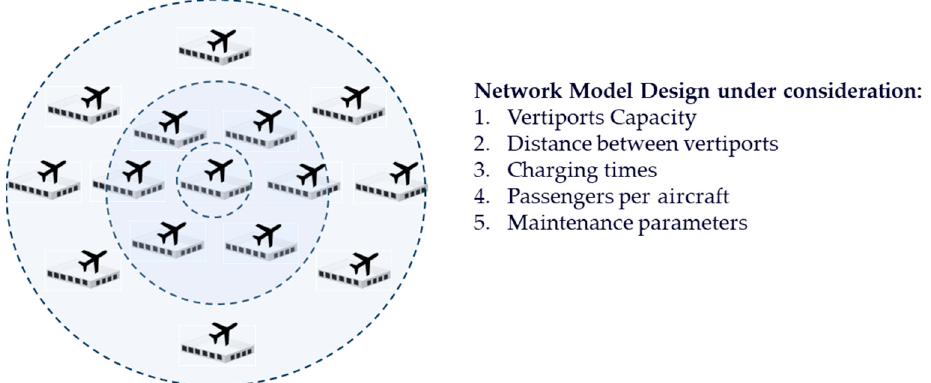
Figure 12. Model Network Design and related parameters.